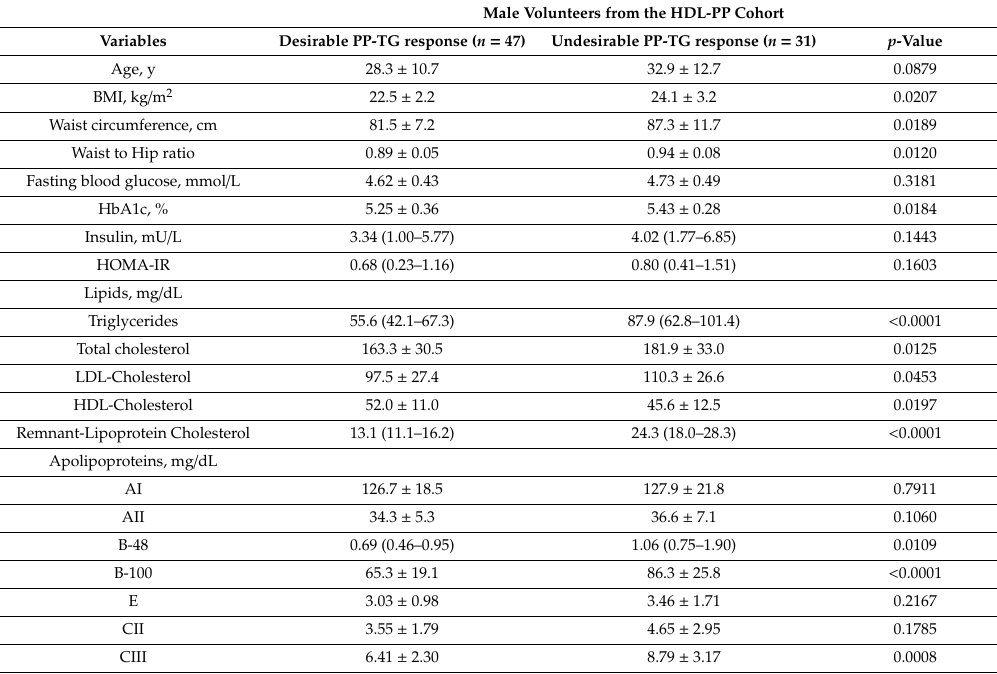
Table 2. Clinical characteristics and fasting lipid parameters of subjects with desirable and undesirable postprandial triglyceride